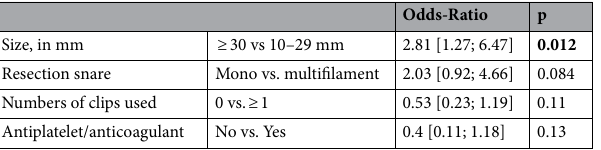
and patients’ or lesions’ characteristics: age, sex, medical history, sporadic or genetic syndrome, the use of anti- platelet agent or anticoagulant, localization of the lesion in the duodenum; nor with resection techniques: type or size of the resection snare, closure with clips, type of endoscope, presence of a cap, type of submucosal lifting solution, adjunction of epinephrine.